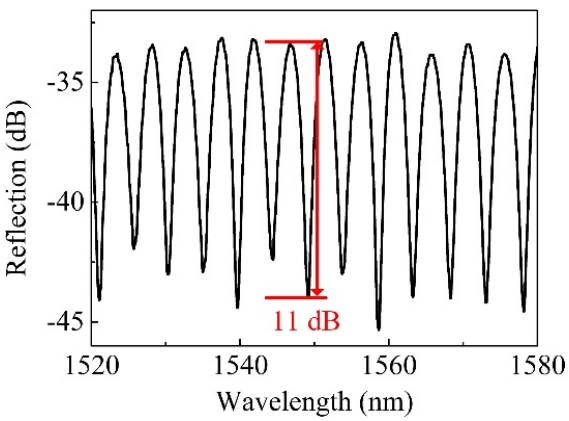
Figure 4. Reflection spectrum of a prepared FPI sensor with optimized HCF parameters ( ID : 4 µm and L : 180 µm).